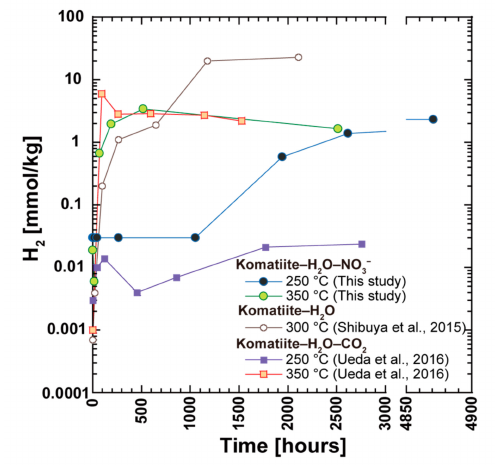
Figure 3. Time-dependent changes in dissolved H 2 concentrations in aqueous fluids in the systems of komatiite–H 2 O–NO 3 − (this study), komatiite–H 2 O–CO 2 [50], and komatiite–H 2 O